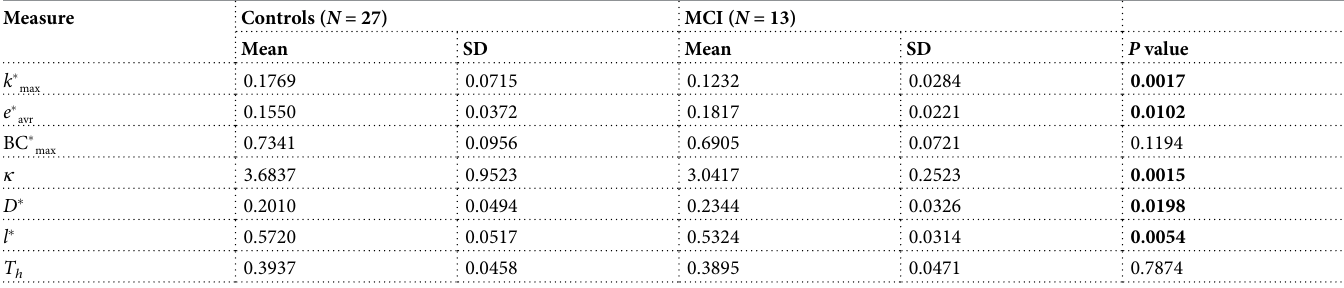
We found that the global average PLI was decreased in MCI patients in the delta band. Post-hoc analysis revealed that the regional average PLI significantly decreased over the right frontal region in patients, and the regional PLI decreased between the right frontal and left central, and between right frontal and right parietal regions. Parietal and frontal cerebral areas are particularly sensitive to brain changes very early on among participants with cognitive Table 5. Minimum spanning tree descriptives in the delta band.